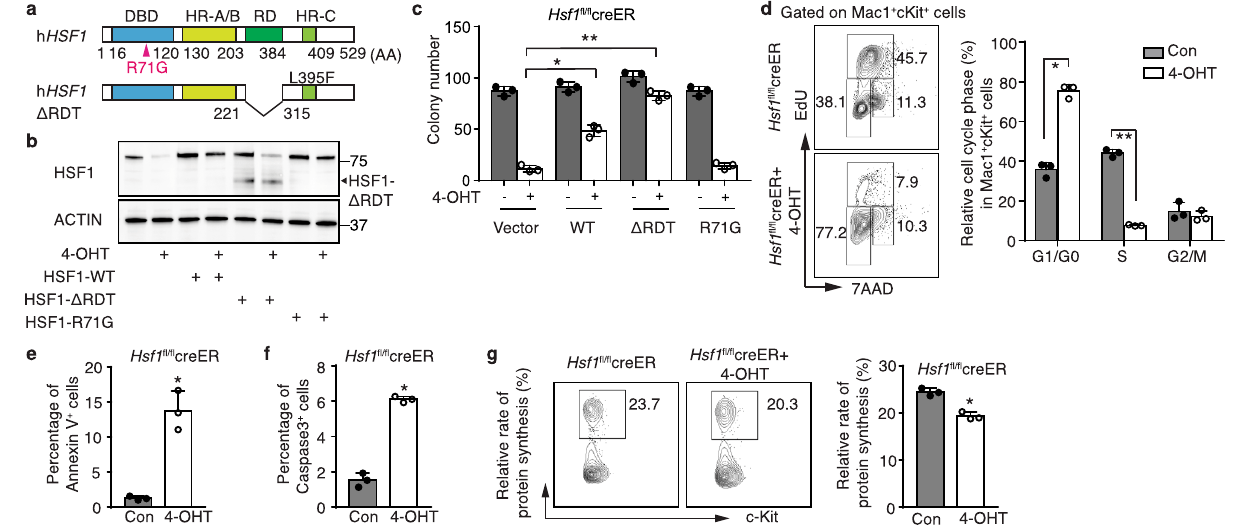
Fig. 3 | HSF1 DNA binding is required for HSF1 function, and deletion of HSF1suppressesLSCproliferationandincreasesLSCapoptosis.a Schemeofthe structure of wild type and mutant alleles of HSF1 . DBD , DNA binding domain; HR , hydrophobic heptad repeat; RD , regulatory domain. HSF1 R71G is an inactive and HSF1 Δ RDT(deletionofregulatorydomainandsubstitutionofleucineataminoacid 395inthe suppression domainofthe trimerizationwithglutamicacid, L395F)isan activemutant. b ExpressionofHSF1anditsmutants( n =3independentreplicates). c ColonynumbersformedusingMLL-AF9 Hsf1 fl / fl creERLSCstransducedwithempty vector, HSF1 WT, inactive R71G mutant, or active Δ RDT mutant in the presence (deletion of endogenous Hsf1 ) or absence of 200nM 4-OHT ( n =3 independent